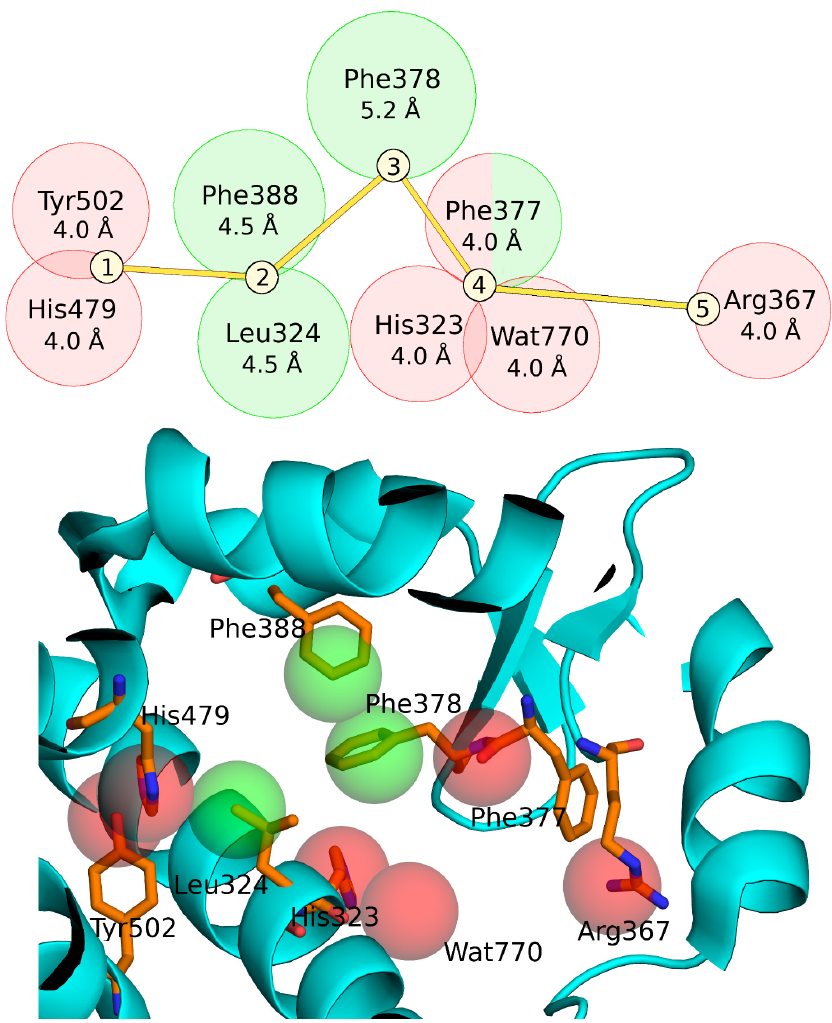
Figure 4. Pharmacophore point model used in SDFCONF filtering. On the top, 2D representation of the pharmacophore point model. Five important binding regions in the LBD of ROR γ t were identi- fied. Two different combinations of the criteria were used in the final SDFCONF screening. Red circles demonstrate radiuses for hydrophilic groups and green circles radiuses for hydrophobic groups in respect to the selected residues. Below, the pharmacophore points depicted in the ROR γ t binding cavity (PDB: 5NTW). The protein is shown in cyan cartoon representation, important resi- dues are shown in sticks with orange C, blue N, and red O atoms. The spheres indicating the posi- tions of the pharmacophore points are colored as in the top figure. Note that the sphere sizes are not scaled to represent the used atom selection radii.